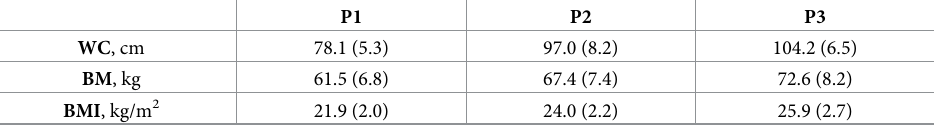
Table 1. Anthropometric characteristics of women in the 1 st (P1), 2 nd (P2) and 3 rd (P3) trimesters of gestation [mean